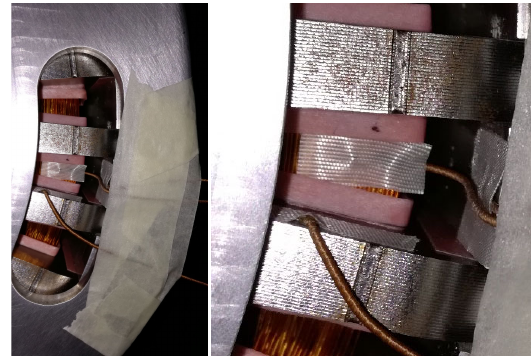
Figure 26. Location of thermocouples for temperature measurement.